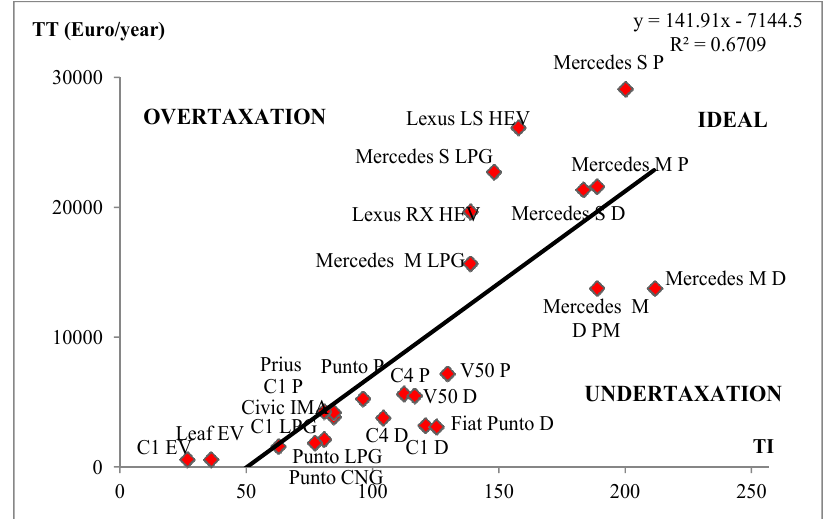
Figure 7. Total taxes (TT) and total environmental impact (TI) of vehicles in the existing fiscal